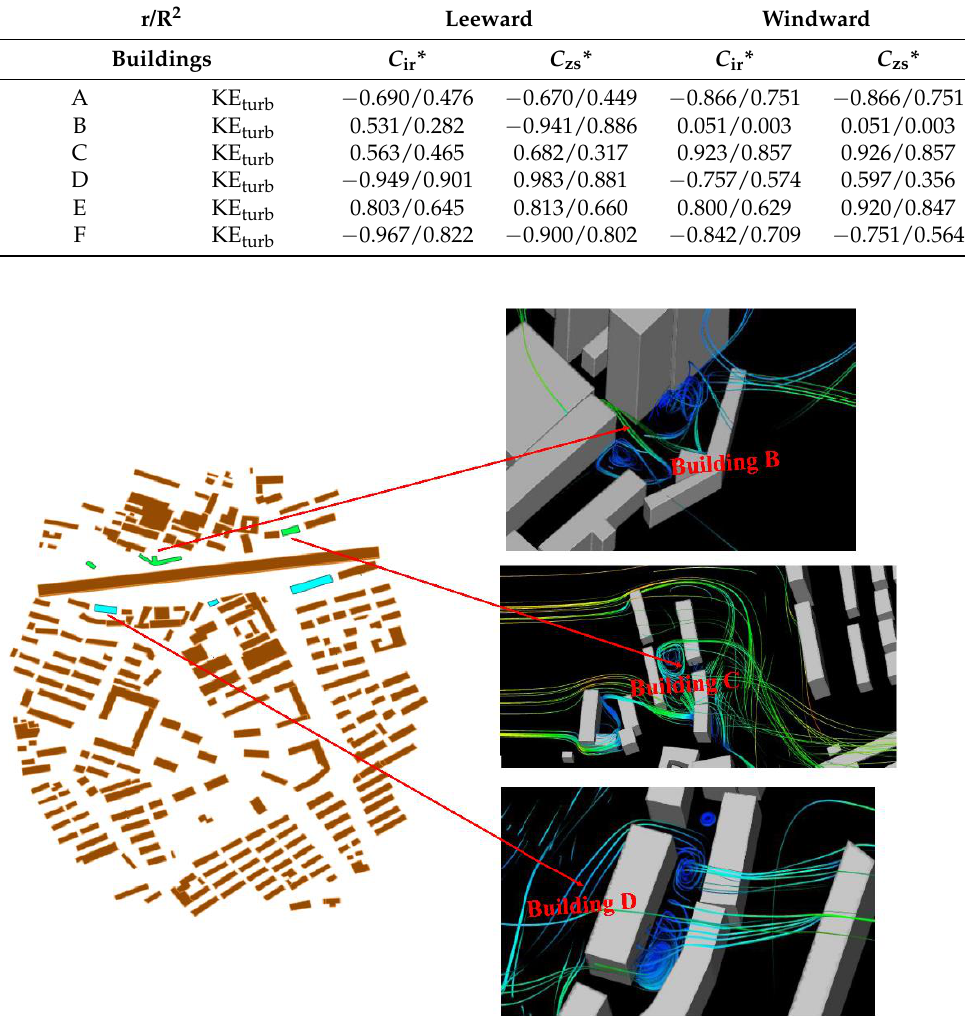
Figure 15. 3D streamline in street canyons.